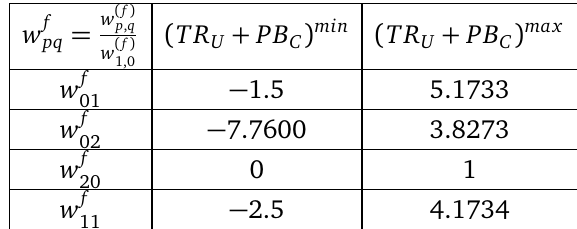
Table 4: A list of graviton bounds obtained using our results TR normalisation M 2 =